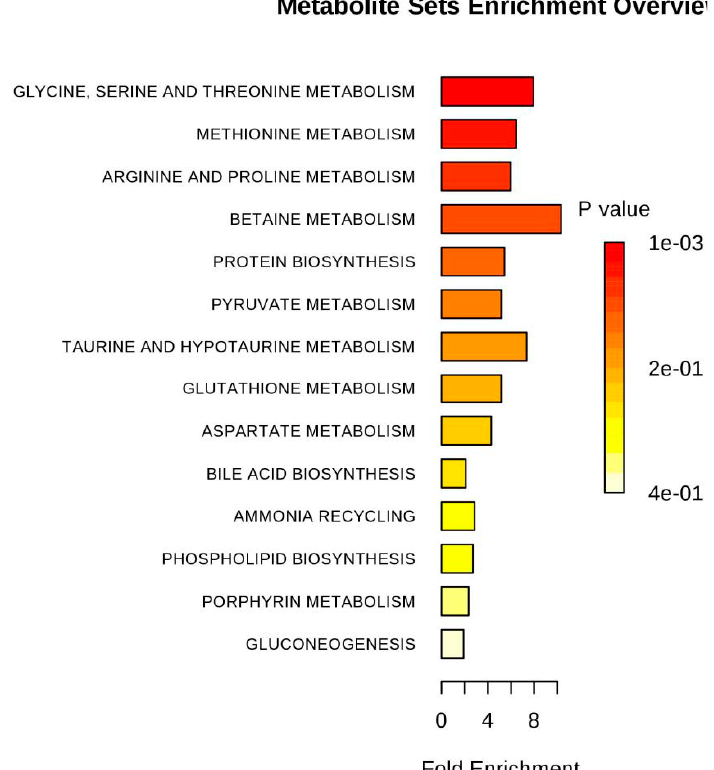
Molecules 2019 , 24 , x FOR PEER REVIEW Figure 11. The pathway analysis of all di ff erential metabolites between SPPM60-D and control groups. Figure 11. The pathway analysis of all differential metabolites between SPPM60-D and control groups.